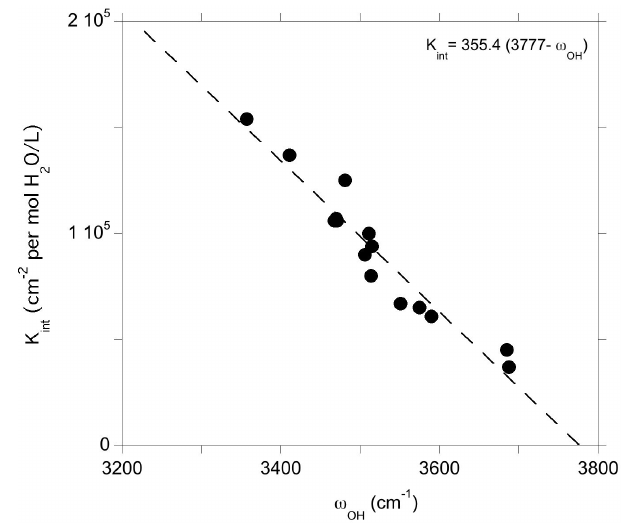
Figure 6. Theoretical integrated absorption coefficient ( K int ) of OH stretching mode as a function of frequency ( ω OH ). Models display- ing multiple bands (models 1, 16 and 19, Table 1) or a frequency significantly lower than those experimentally observed (model 4, Table 1) have not been included in the figure.